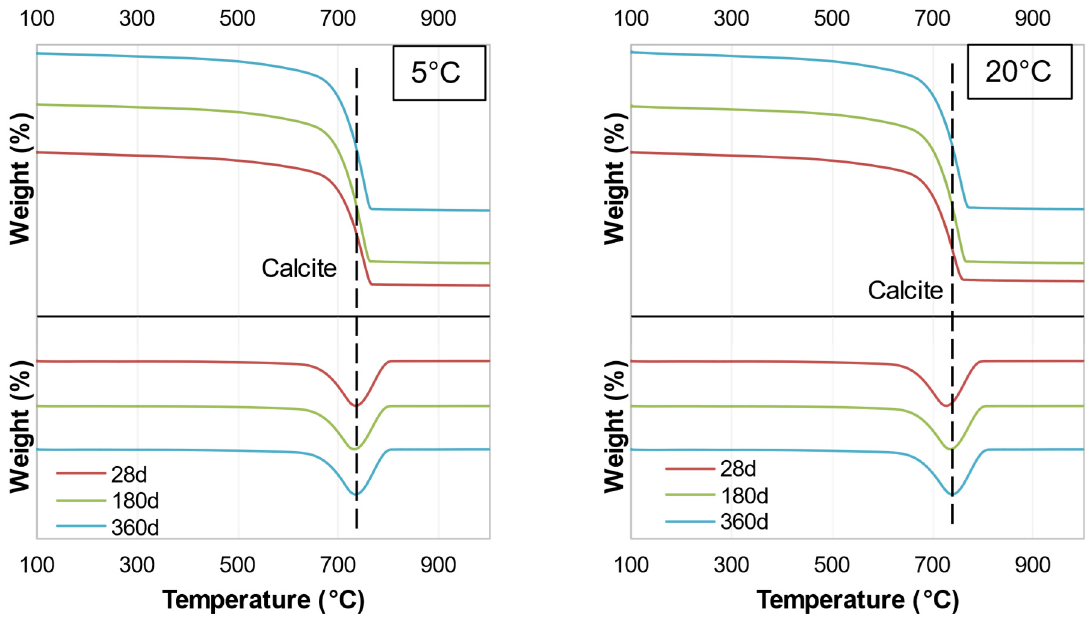
Figure 18. TGA traces of Sg + S + F + W2.